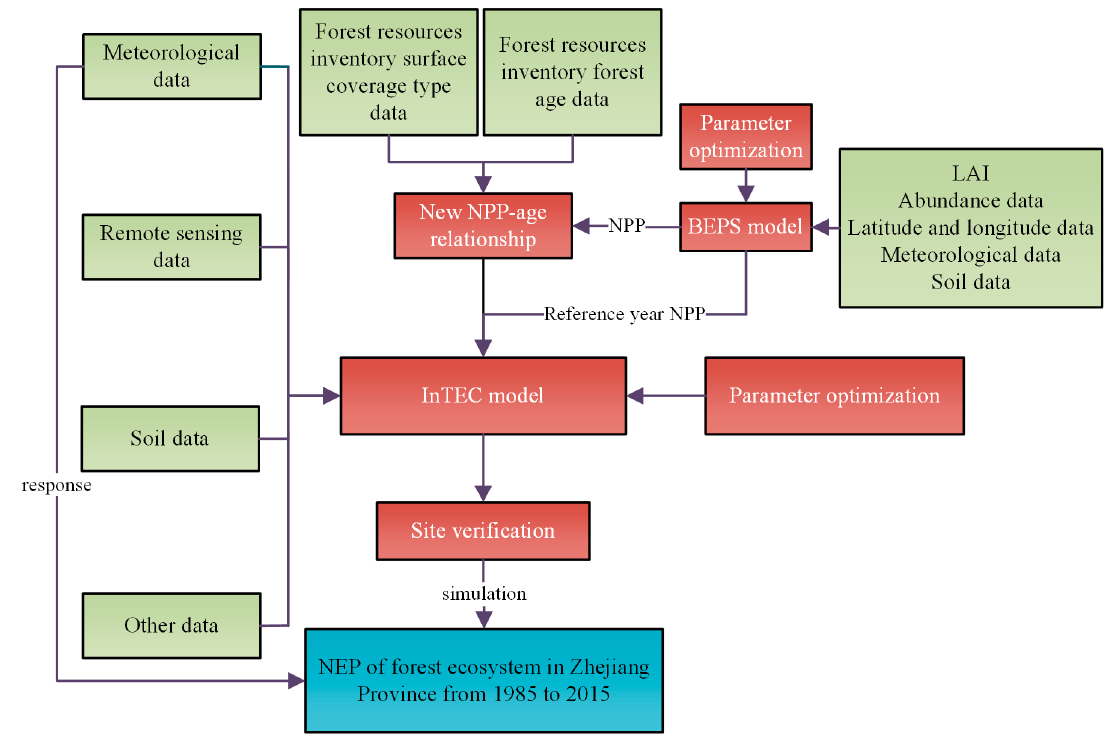
Figure 3. Flow chart for the simulation.